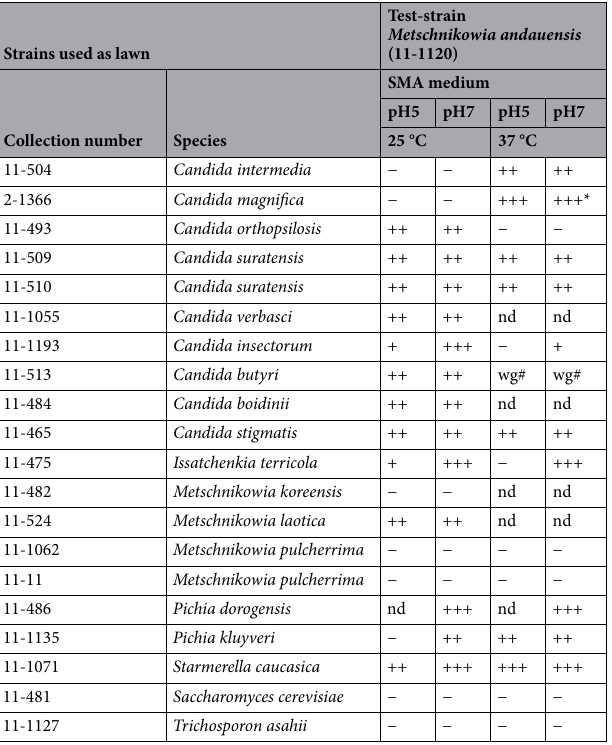
Table 2. Metschnikowia andauensis can inhibit growth of wild yeast. + : presence of the inhibitory zone (the number of + indicates the degree of inhibition). − : absence of the inhibitory zone. nd: inhibition was not determined because of the weak growth of the lawn. wg#: weak growth of M. andauensis on the given lawn. *See Fig.